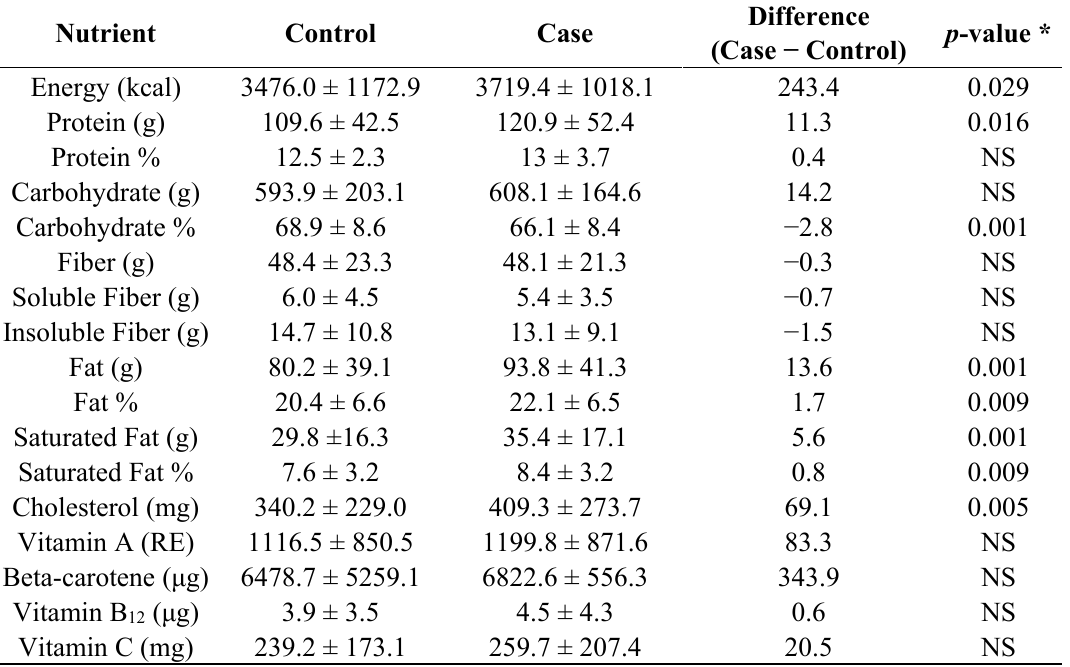
Table 2. Mean intake per day ± SD of nutrients for the study